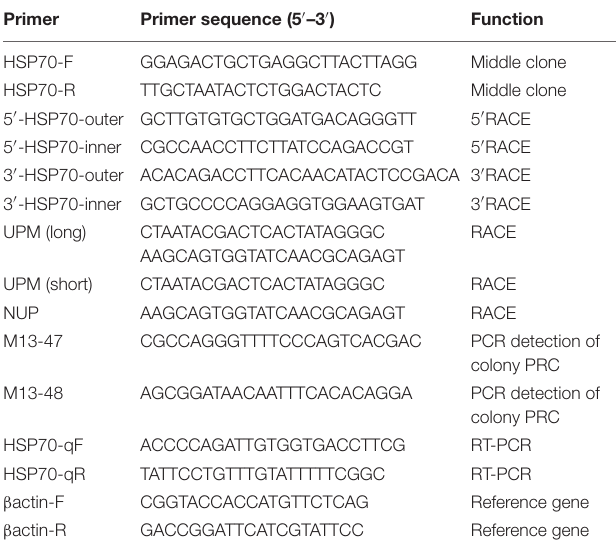
TABLE 1 | Primers used in the study of PmHSP70